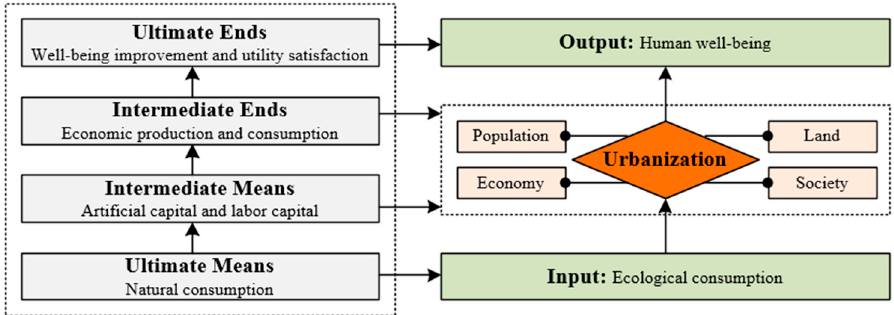
Figure 2. The input–output mode (IOM) for EWP evaluation.